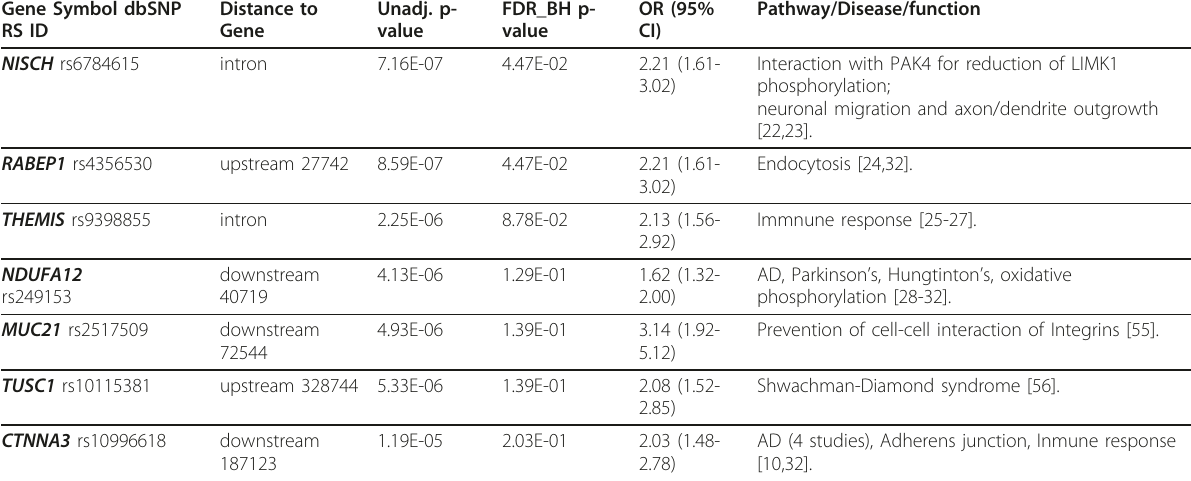
Table 1 Logistic regression top scoring SNPs, approach I